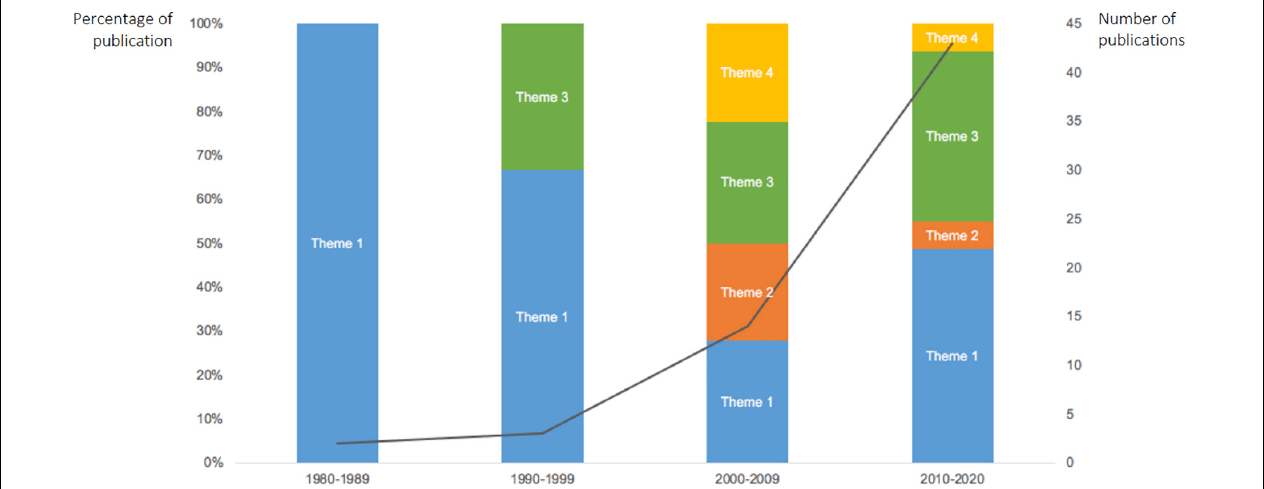
FIGURE 6 | An illustrated summary of the shifts in research interests across the last four decades. Theme 1, humor styles and effects; Theme 2, humor as a communication tool and discursive resource; Theme 3, variables in the humor and leadership relationship; Theme 4, cultural context. The trend line represents the number of publications of each